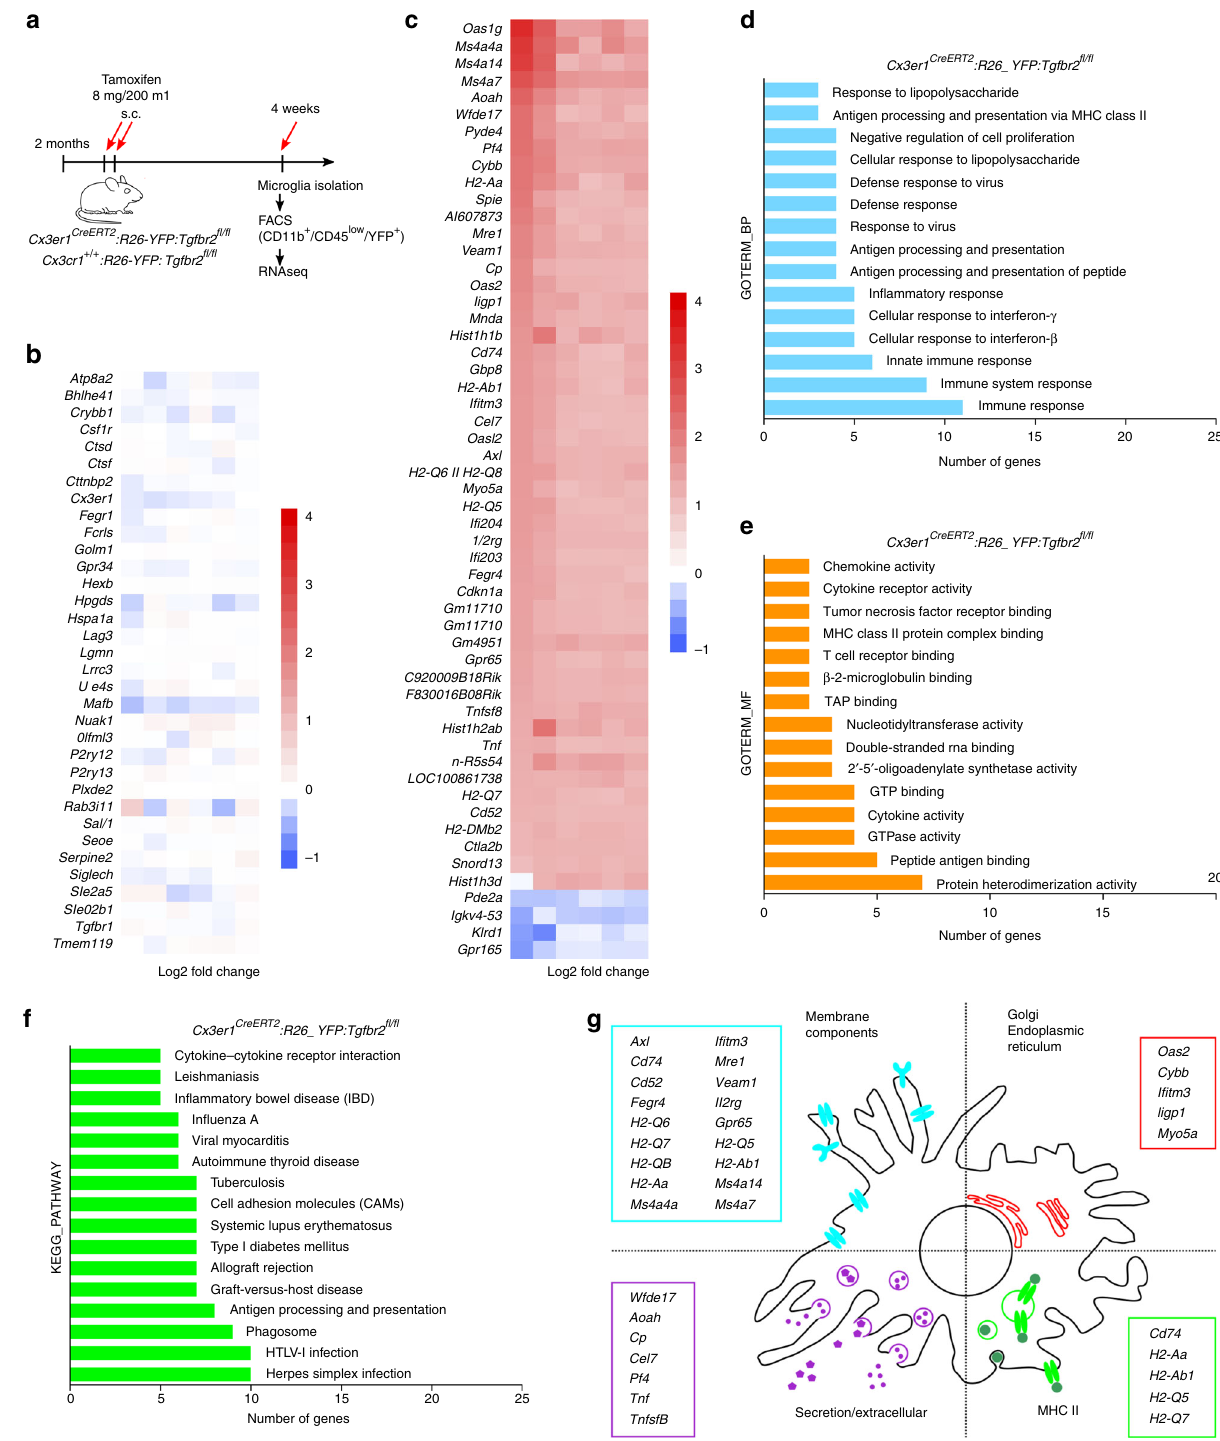
Fig. 4 Gene expression pattern of Tgfbr2-de fi cient microglia indicates microglia activation and increased immune responses. a A timeline depicting TAM- treatment and microglia isolation/sorting for RNA isolation. b Heatmap analysis of RNAseq expression data of microglia isolated after TAM-induced recombination of Cx3cr1 CreERT2 :R26-yfp,Tgfbr2 fl / fl mice ( n = 6). TAM-induced Cx3cr1 + / + :R26-yfp,Tgfbr2 fl / fl mice ( n = 6) were used as controls displaying